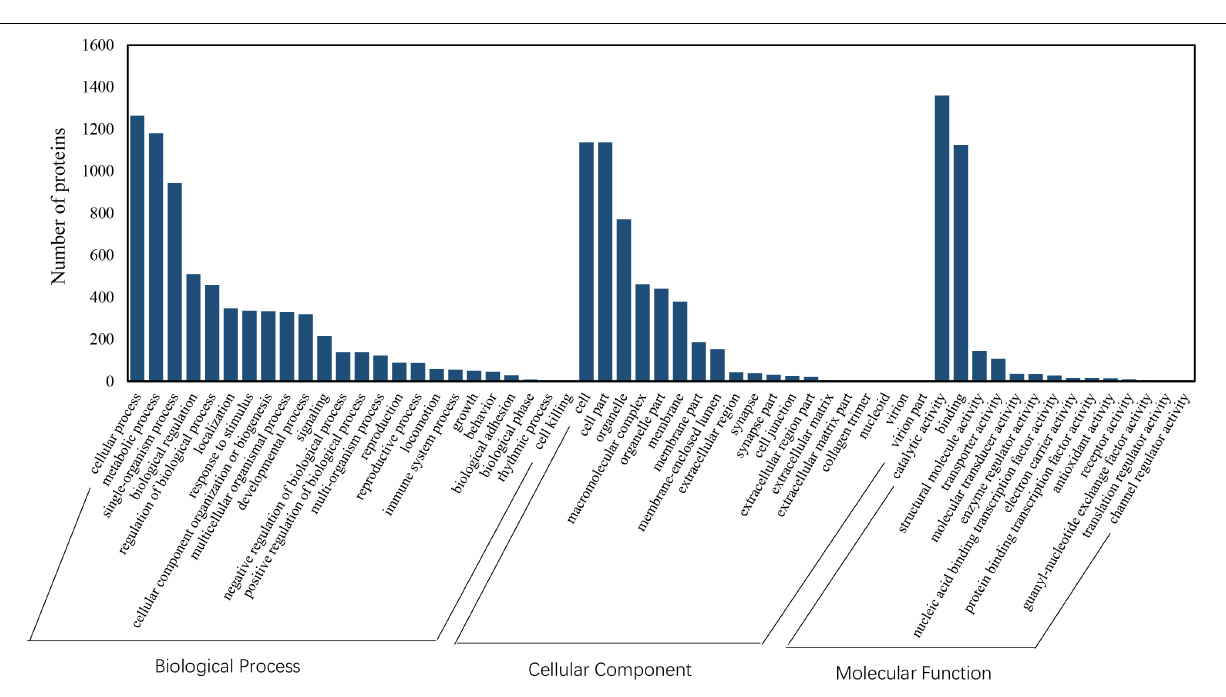
FIGURE 7 | GO classification of proteins identified in N. barkeri female adults. The proteins are grouped into three hierarchically structured GO terms, biological process, cellular component, and molecular